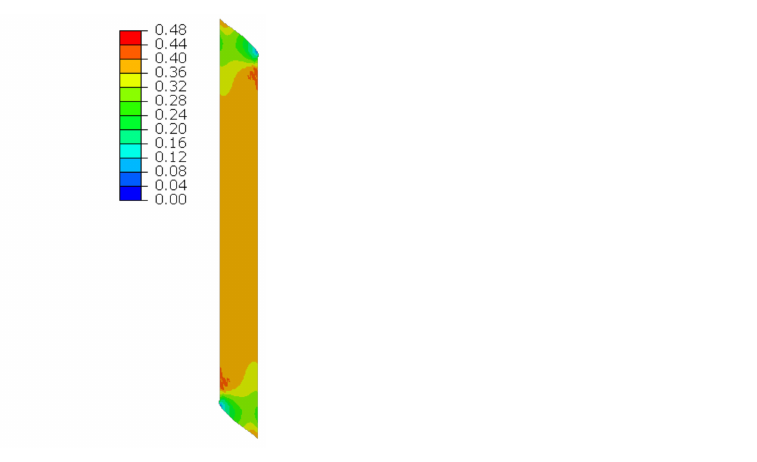
Figure 27. Deformations for scaling factor 1.0 and Cauchy stresses τ zy in MPa for total load level. The width of the gap is equal to 1.0 cm, left graphic, and 2.0 cm, right graphic.